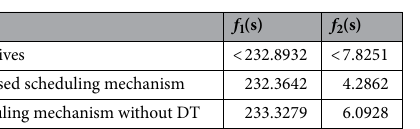
Figure 15. Unit level rescheduling.